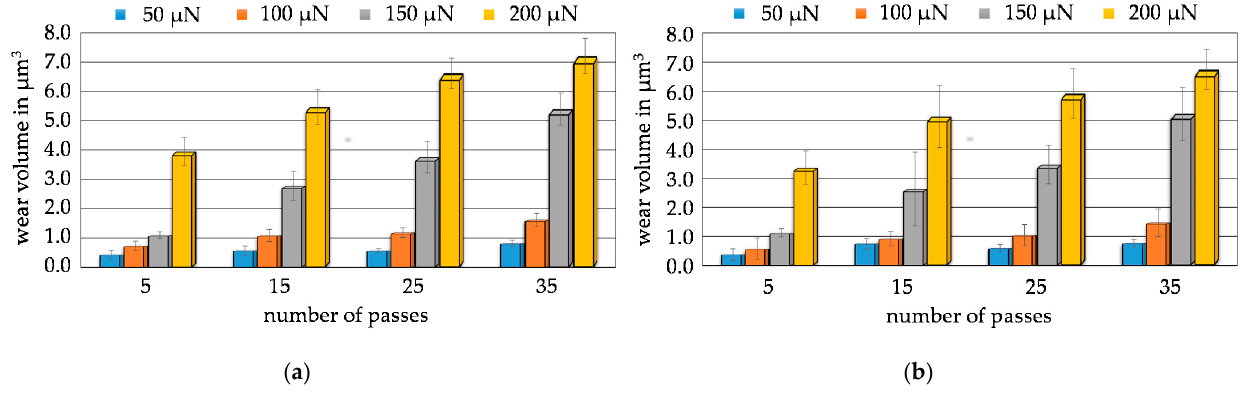
Figure A1. Determined wear volumes with standard deviation of the respective parameter combination. ( a ) Volume de ‐ termination via subtraction of post ‐ scan and pre ‐ scan of the Mo ‐ coating. ( b ) Volume determination only via post ‐ scan of the Mo ‐ coating.